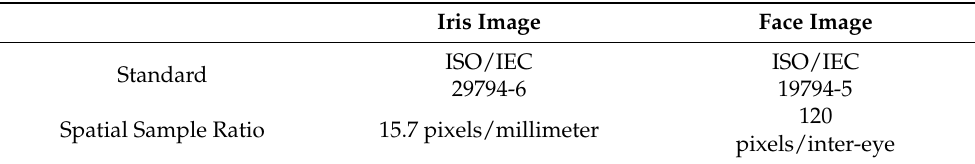
Table 1. Comparison of spatial sample ratio based on ISO